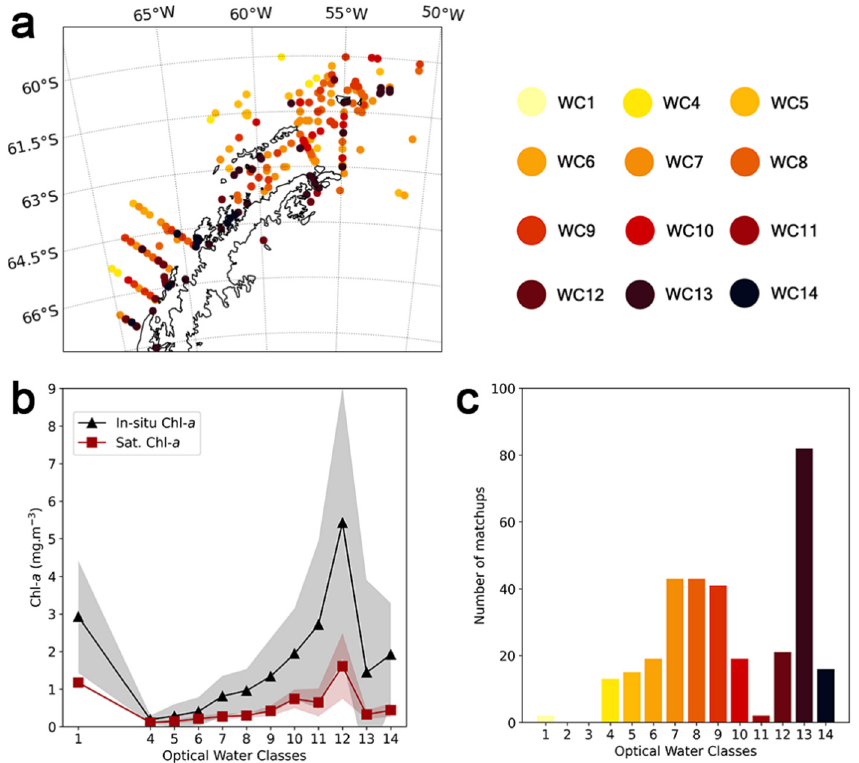
Figure 4. ( a ) CCI 4.2 dominant optical water class distribution in the Western Antarctic Peninsula. ( b ) Mean and standard deviation (shaded area) of satellite (red) and in-situ (black) Chl- a (mg m − 3 ) for each optical water class. ( c ) Number of match-ups identified per dominant optical water class.